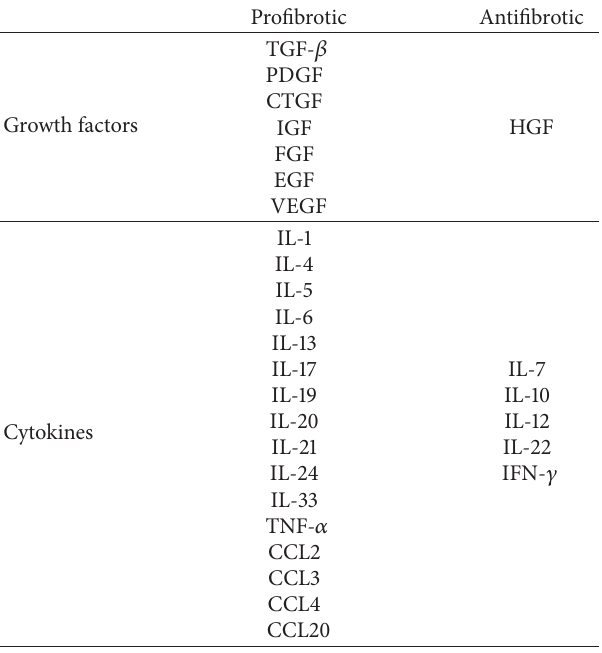
TGF: tumor growth factor; PDGF: platelet-derived growth factor; CTGF: connective tissue growth factor; IGF: insulin-like growth factor; FGF: fibroblast growth factor; EGF: epidermal growth factor; VEGF: vascular endothelial growth factor; HGF: hepatocyte growth factor; IL: interleukin; TNF: tumor necrosis factor; CCL: chemokine (C-C motif) ligand; IFN: